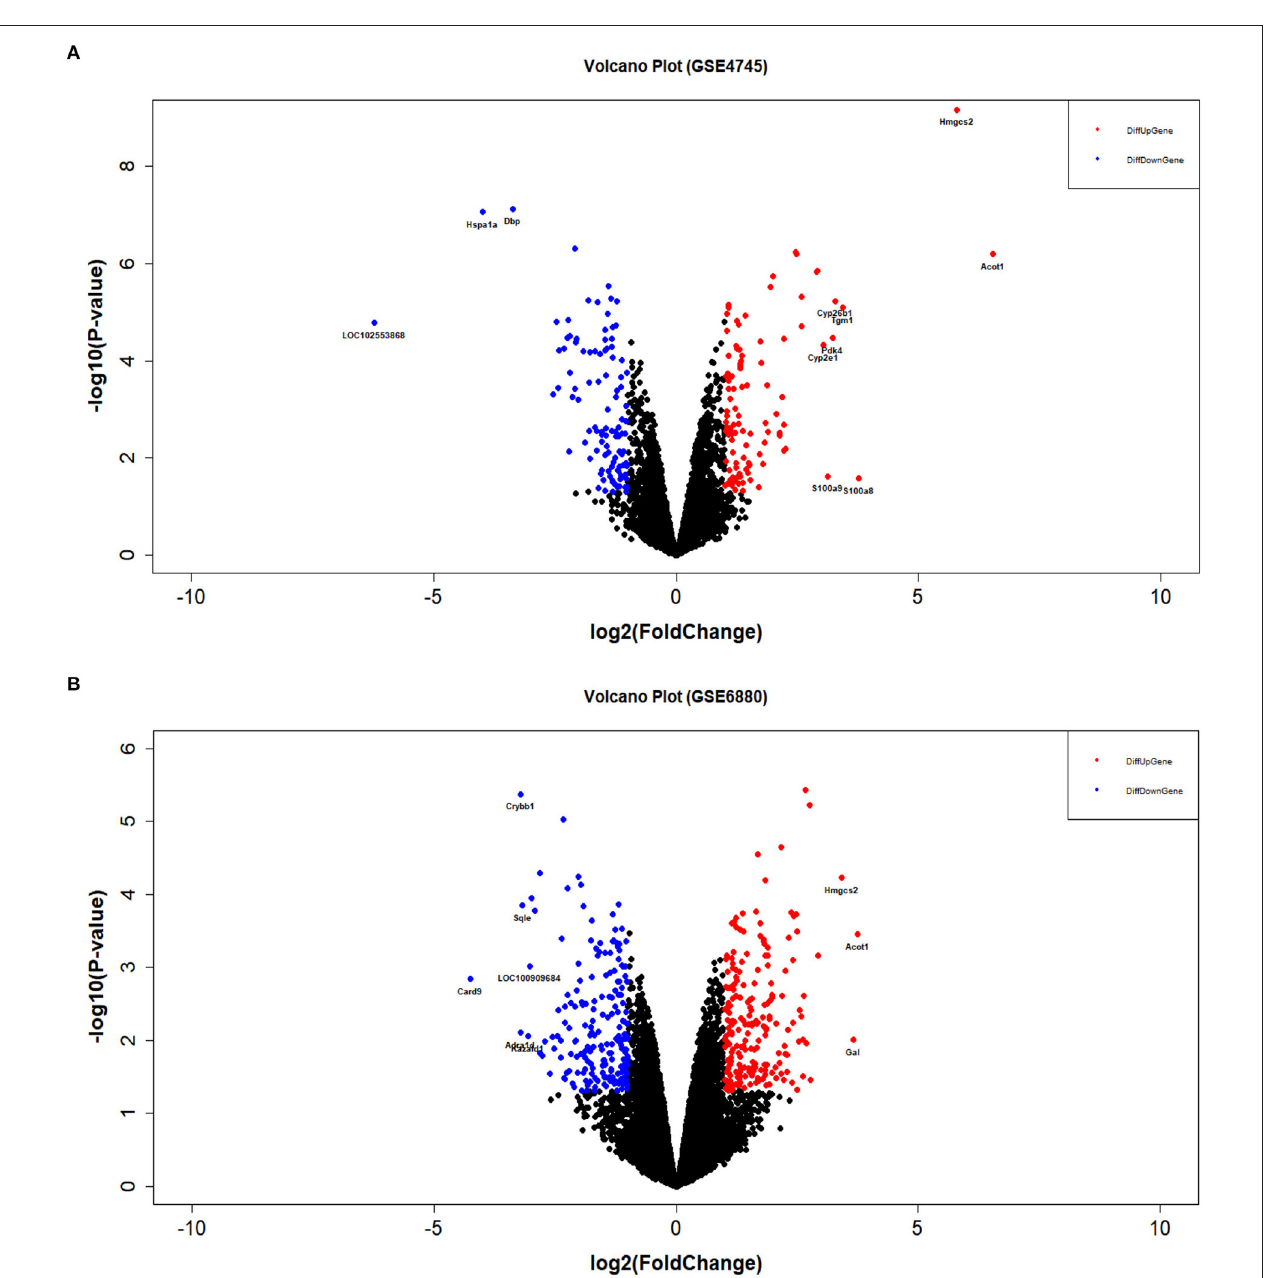
FIGURE 3 | Volcano plots of DEGs between normal and diabetic heart samples in datasets GSE4745 and GSE6880. (A) Volcano plot of DEGs in dataset GSE4745. (B) Volcano plot of DEGs in dataset GSE6880. The blue dots represent differentially down-regulated genes (logFC ≤ − 1 & P < 0.05). The red dots represent differentially up-regulated genes (logFC ≥ 1 & P < 0.05). FC, fold